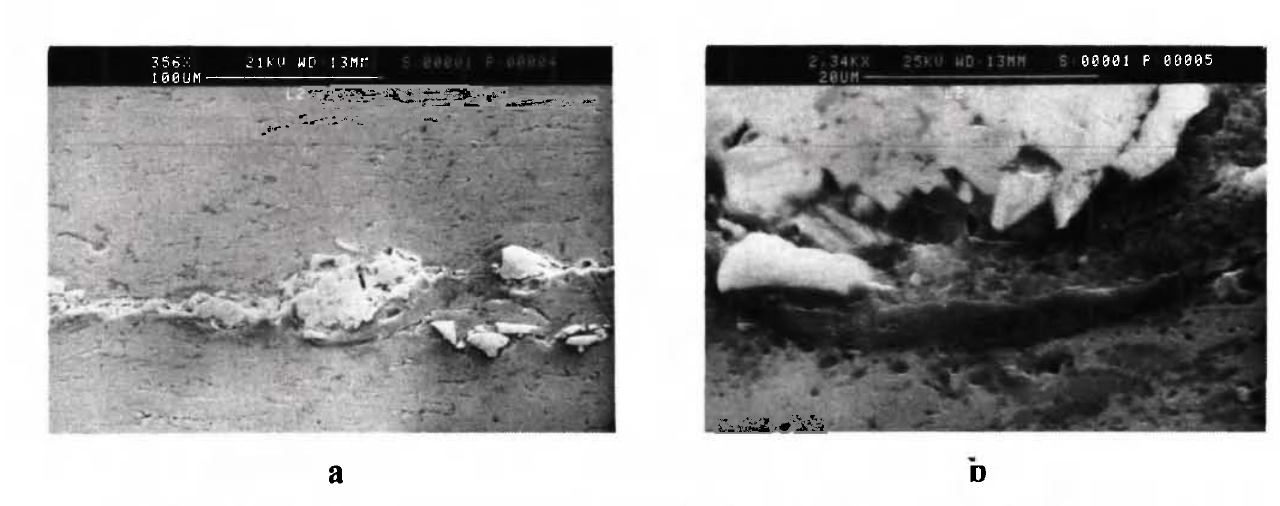
a D Fig. 2: The particles and their adjacent matrix layer act as rigid obstacles for the matrix yielding and rotate during plastic deformation (2a, 2b - different magnifications)